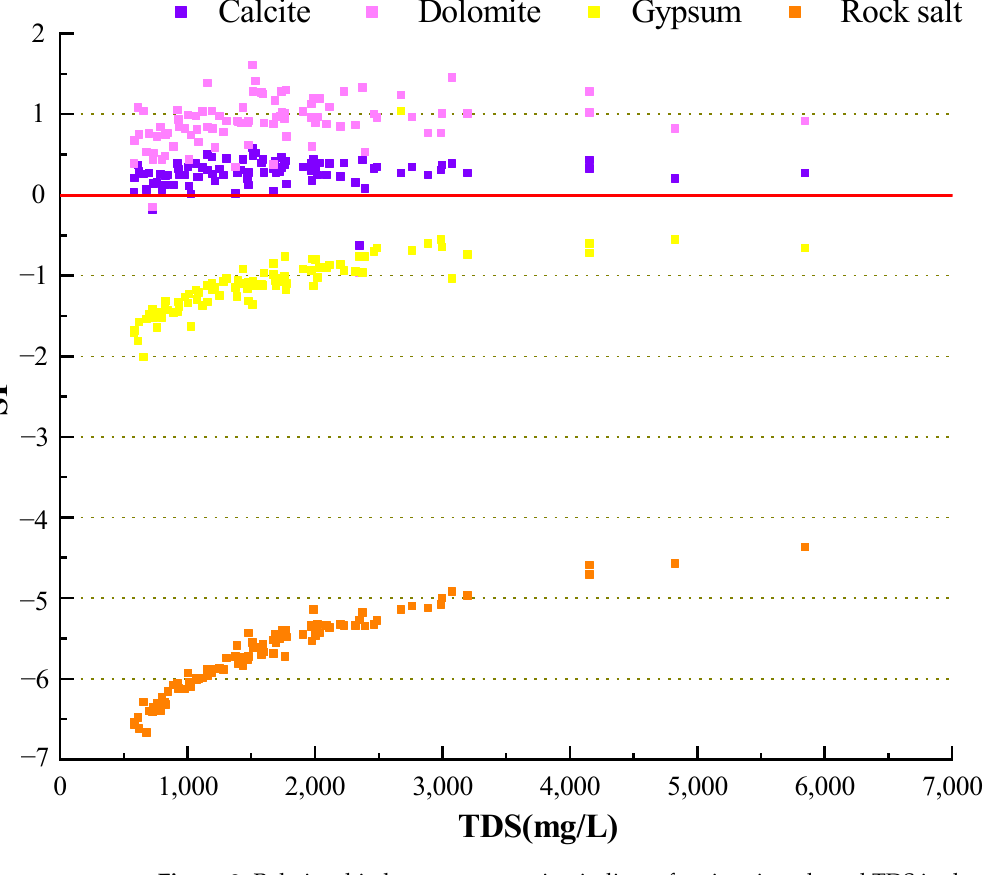
Figure 9. Relationship between saturation indices of main minerals and TDS in the study area.